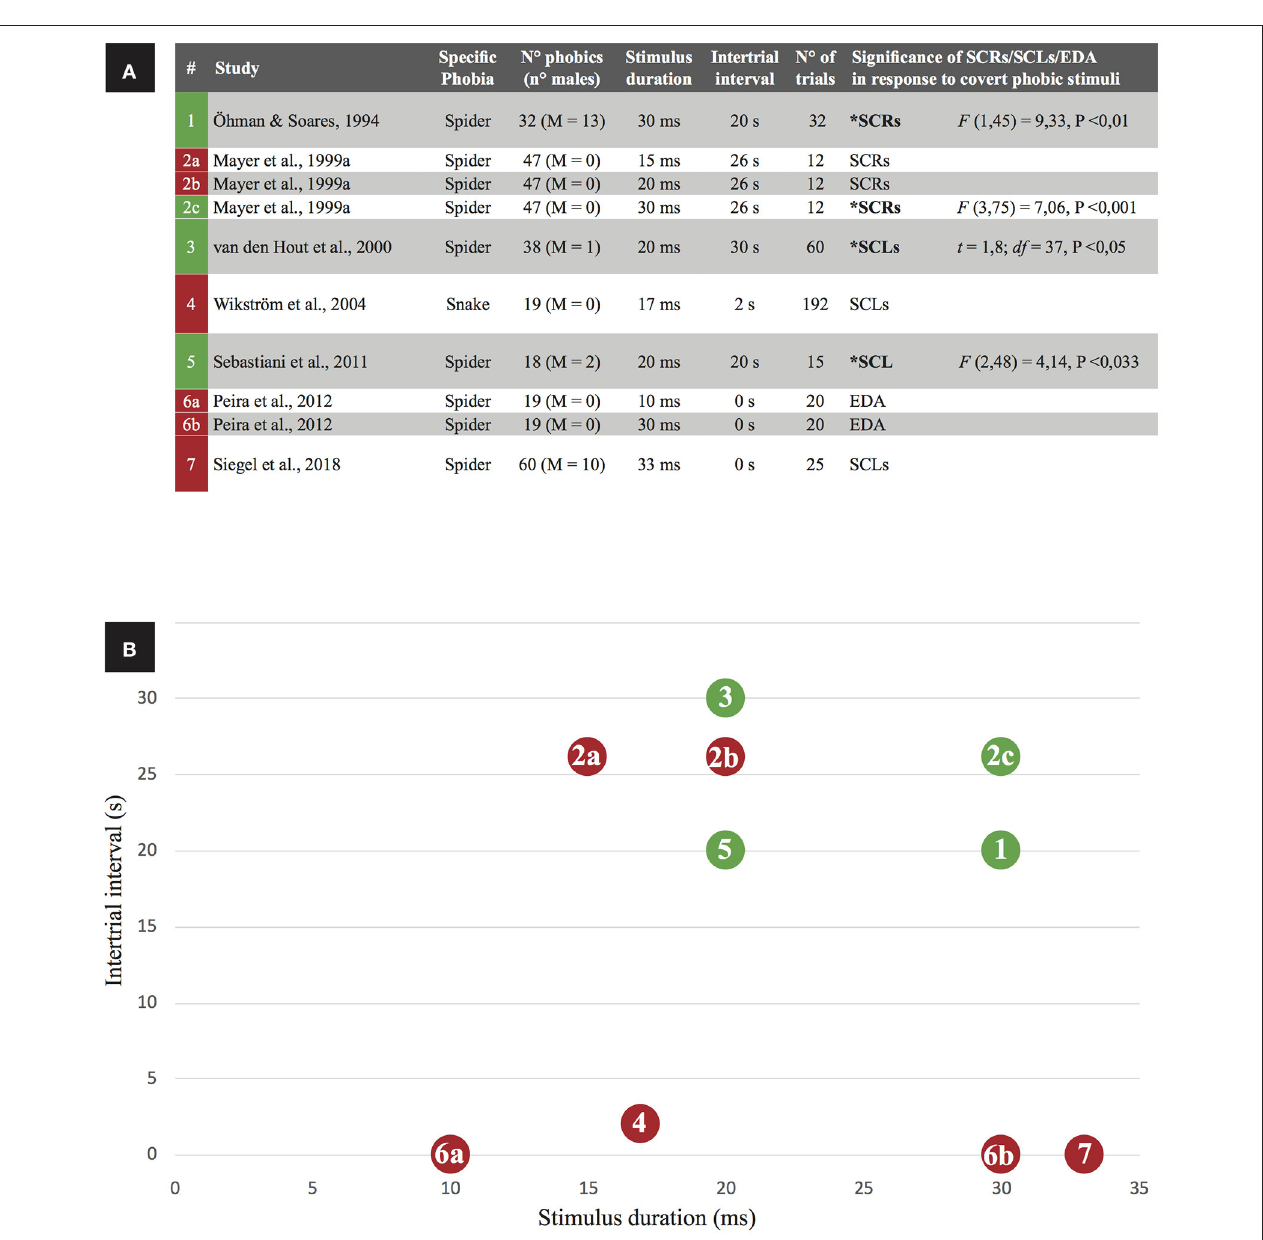
FIGURE 2 | Skin conductance as a correlate of phobic subliminal stimulation in the retrieved studies. (A) Green box indicates a study with positive results (significant increases of skin conductance levels are reported), a red box indicates negative results. For each paper, exposure properties of the phobic stimulus (duration, intertrial interval, number of trials) are listed: based on stimulus duration and intertrial interval, (B) visually represents the relation between those variables in predicting the significance of skin conductance